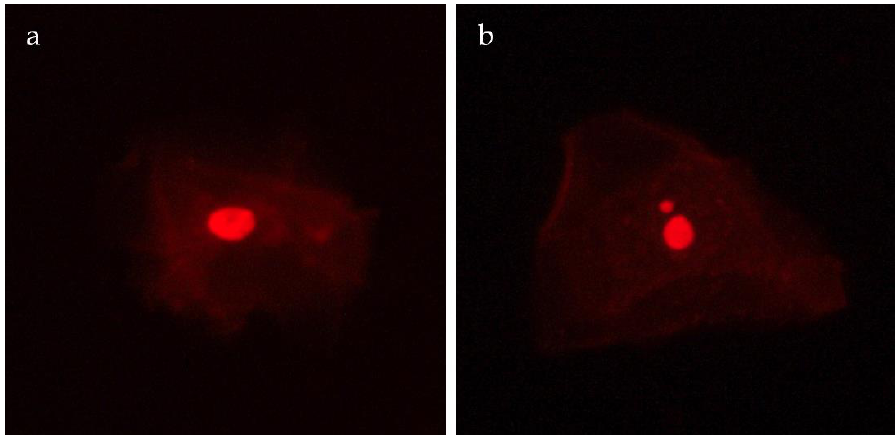
Figure 2. Normal differentiated cell ( a ) and cell with a micronucleus ( b ) observed by fluorescence Figure 2. Normaldifferentiatedcell( a )andcellwithamicronucleus( b microscope.